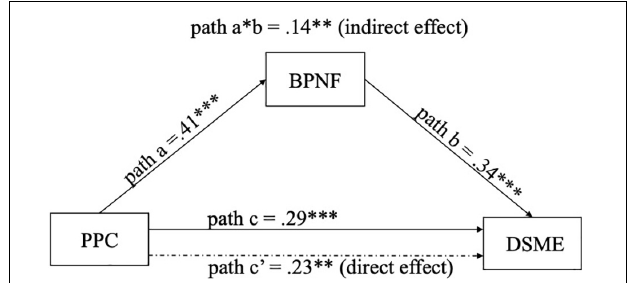
FIGURE 4 | Relationships between BPNF, PPC, and DSME. PPC, parental psychological control; BPNF, basic psychological need frustration; DSME, dysregulation in social media engagement.